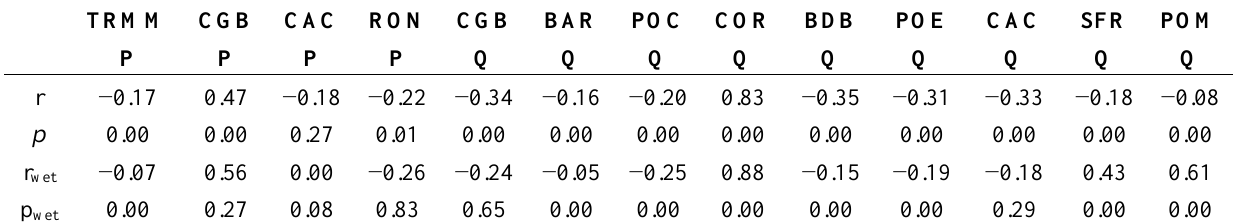
Table 6. Correlation coefficients (r) between precipitation (P) or discharge (Q) and simulated actual evaporation (AET) as well as correlation coefficients (r wet ) between wet season precipitation or wet season discharge and simulated AET and their p -values for considered INMET ( Instituto Nacional de Meteorologia : National Institute of Meteorology) and Hidroweb stations from ANA ( Agência Nacional de Águas : National Water Agency in Brazil) in the study area (Figure 1a).